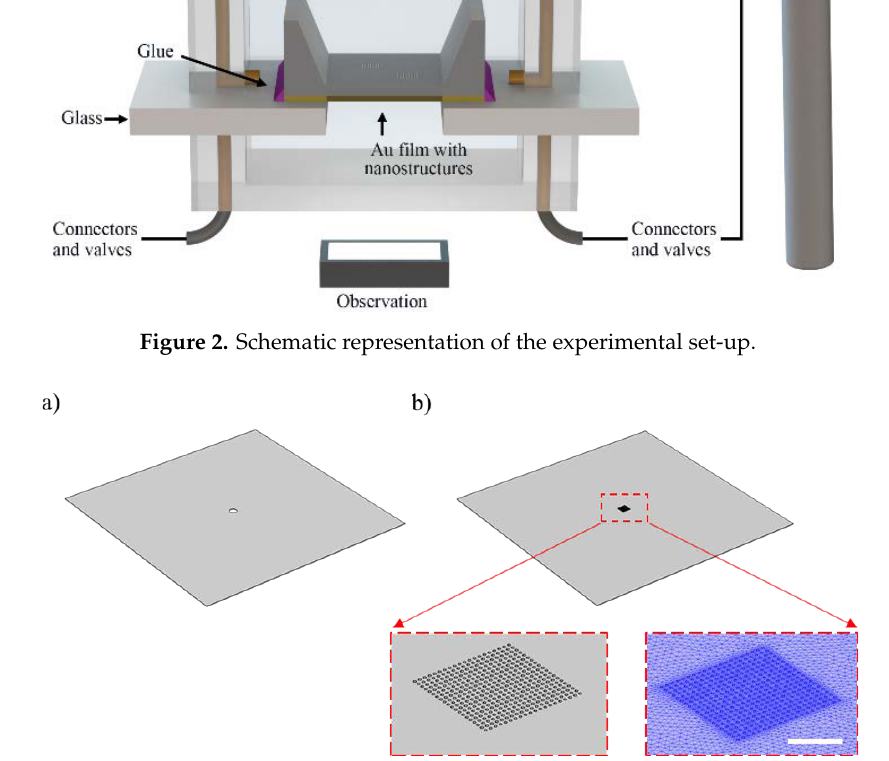
Figure 3. Computer-aided design (CAD) models used for the finite element method (FEM)-based simulations. ( a ) CAD model used for linear elastic simulations. ( b ) CAD model used for the nonlinear elastic simulations. A detail of the nanoapertures in the CAD model and the corresponding mesh are shown as insets. Scale bar represents 10 µm.